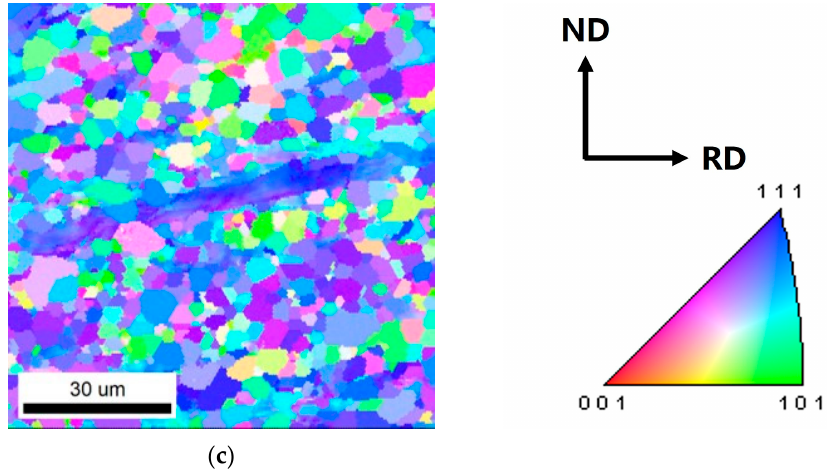
Figure 4. Inverse pole fi gure (IPF) of annealed Ti 50 Ni 47 Fe 3 alloys. ( a ) 400 °C/60 min/AC; ( b ) 500 °C/60 min/AC; and ( c ) 600 °C/60 min/AC .